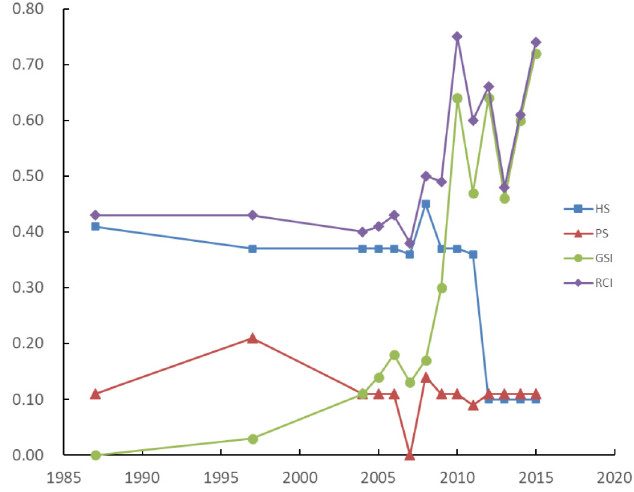
Fig. 3. The Restoration Capacity Index (RCI) of the restoration potential of wild large yellow croaker in Guanjingyang and the performance of Habitat Suitability (HS), Population Status (PS) and Government Social Interventions (GSI) from 1987 to